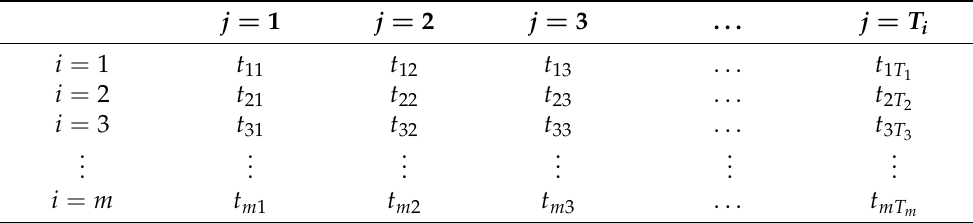
Table 1. The tolerance t ij resulting from manufacturing part i through production strategy j . j = 1 j = 2 j = 3 . . . i =